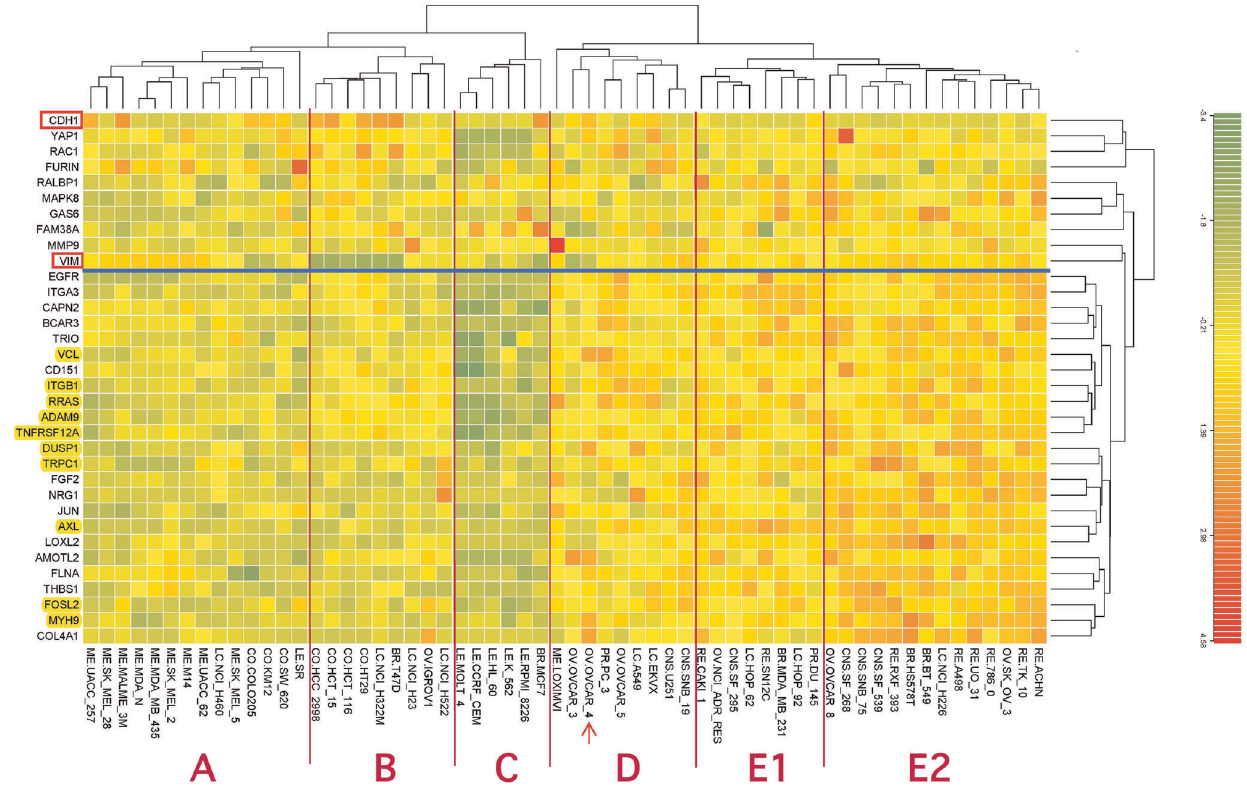
Figure 4. Clustered image map (CIM) of the relative expression of the 32 genes in Figure 3 in each of the NCI-60 cell lines. In addition, the CIM includes CDH1 (E-cadherin, a marker genes for epithelial character) and VIM (vimentin, a marker genes for mesenchymal character). The CIM image (Euclidean norm, complete linkage) was computed using custom in-house R language code. The genes below the blue line are the 24 genes in high cross-correlation set HCCS24 (above the blue line in Figure 3 and marked red in Figures 11 and 12 ). Genes that were also in HCCS15 (Figure 2) are highlighted in yellow. The vertical red lines help to discern which cell lines of a given tissue type cluster together, which deviate, and which fall into a cluster dominated by a different tissue type. The arrow points to ovarian carcinoma cell line OVCAR4, which was unusual in showing high expression of both CDH1 and VCL.